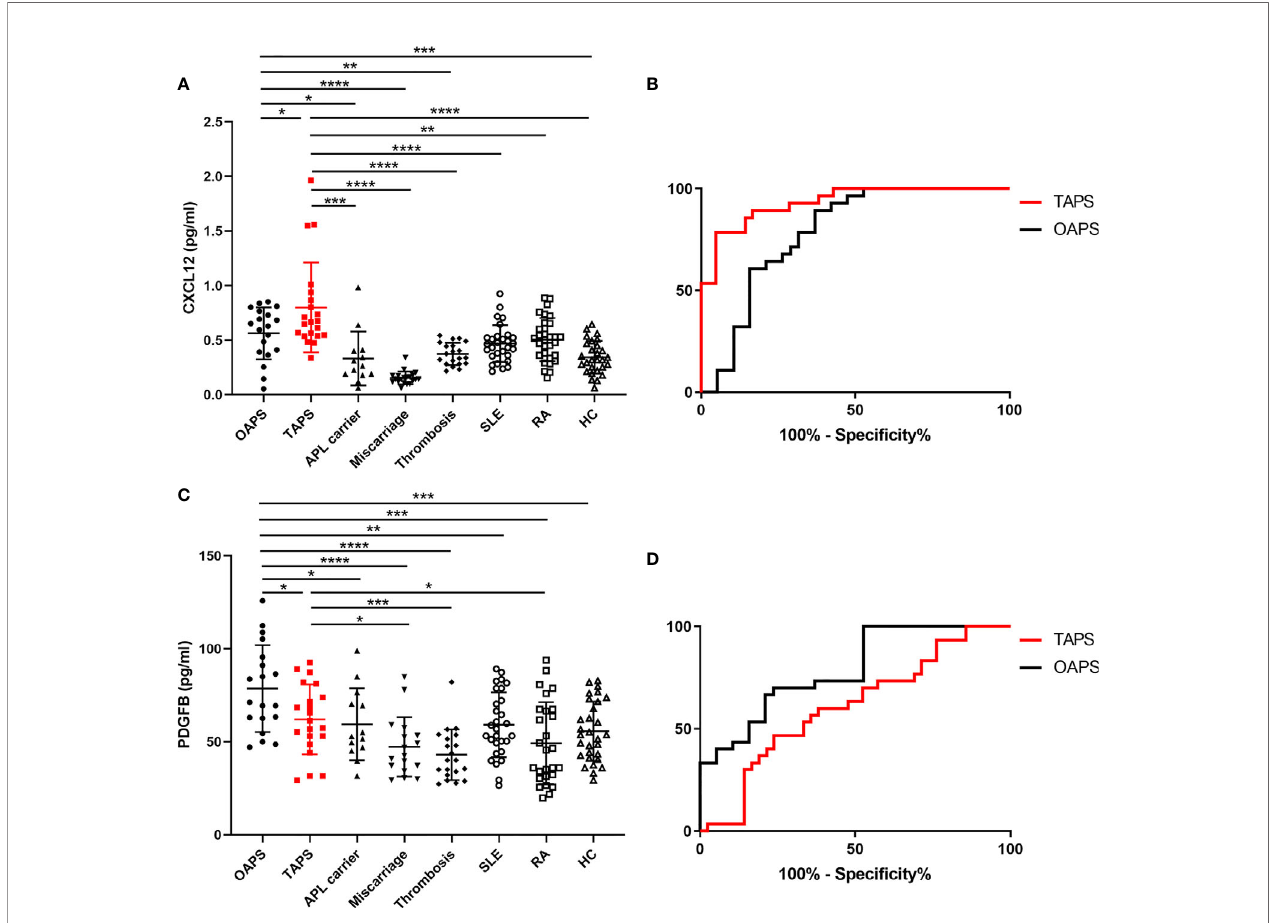
FIGURE 4 | Validation of CXCL12 and PDGFB as urinary biomarkers for patients with OAPS and patients with TAPS, respectively. (A) CXCL12 levels in the urine of patients with OAPS, patients with TAPS, APL carriers, patients with miscarriages, patients with thrombosis, systemic lupus erythematosus (SLE), rheumatoid arthritis (RA) and healthy controls (HCs). (B) The ROC curves of CXCL12 levels in the urine of TAPS vs HCs and that of OAPS vs HCs. (C) PDGFB levels in the urine of OAPS, TAPS, APL carriers, patients with miscarriages, patients with thrombosis, SLE, RA and HCs. (D) The ROC curves of PDGFB levels in the urine of TAPS vs HCs and that of OAPS vs HCs. * p < 0.05, ** p < 0.01, *** p < 0.001, **** p <